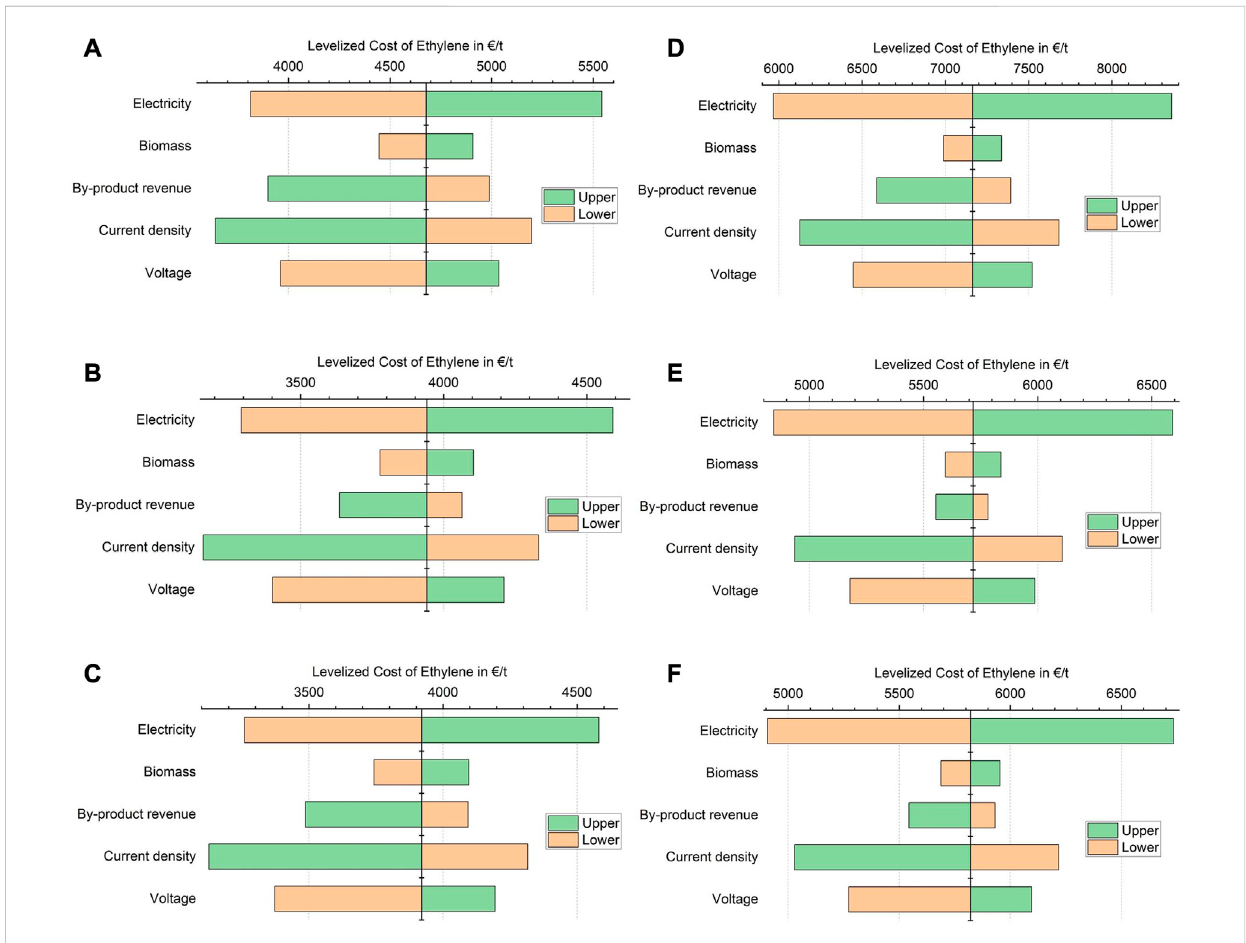
FIGURE 8 Impact of input parameters on the LCOE for G1 (A) , G1-O (B) , G2 (C) , C1 (D) , C1-O (E) , and C2 (F) (Electricity price: Base: 60 € /MWh, Lower: 40 € /MWh, Upper: 80 € /MWh/Biomass price: Base: 20 € /MWh Lower: 10 € /MWh Upper: 30 € /MWh/Revenue from side products: Base: 100% Lower: − 20% Upper: +50%/Current density of COR: Base: 300 mA/cm 2 , Lower: 250 mA/cm 2 , Upper: 500 mA/cm 2 /Voltage of COR: Base: 3, 5 V, Lower: 2, 5 V, Upper: 4